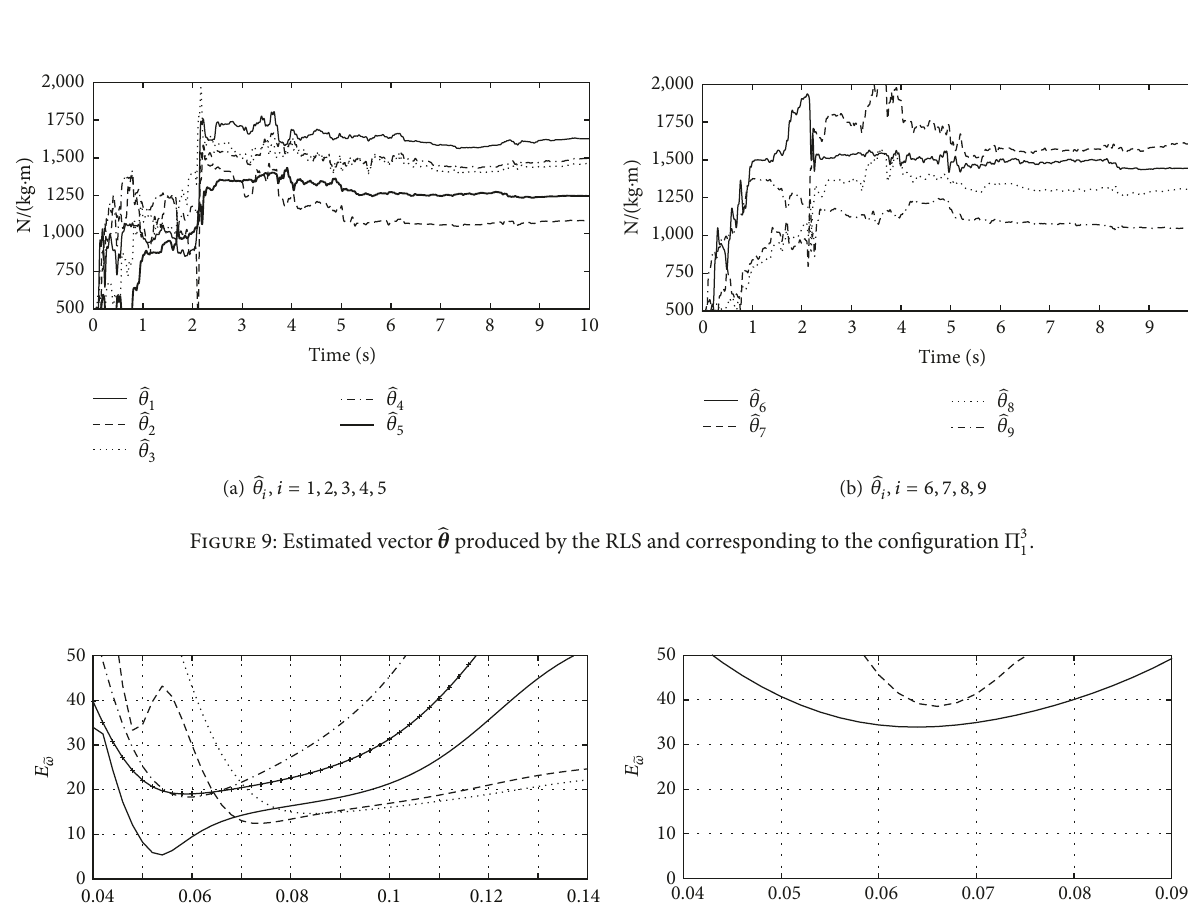
Figure 8: Reconstructed signals